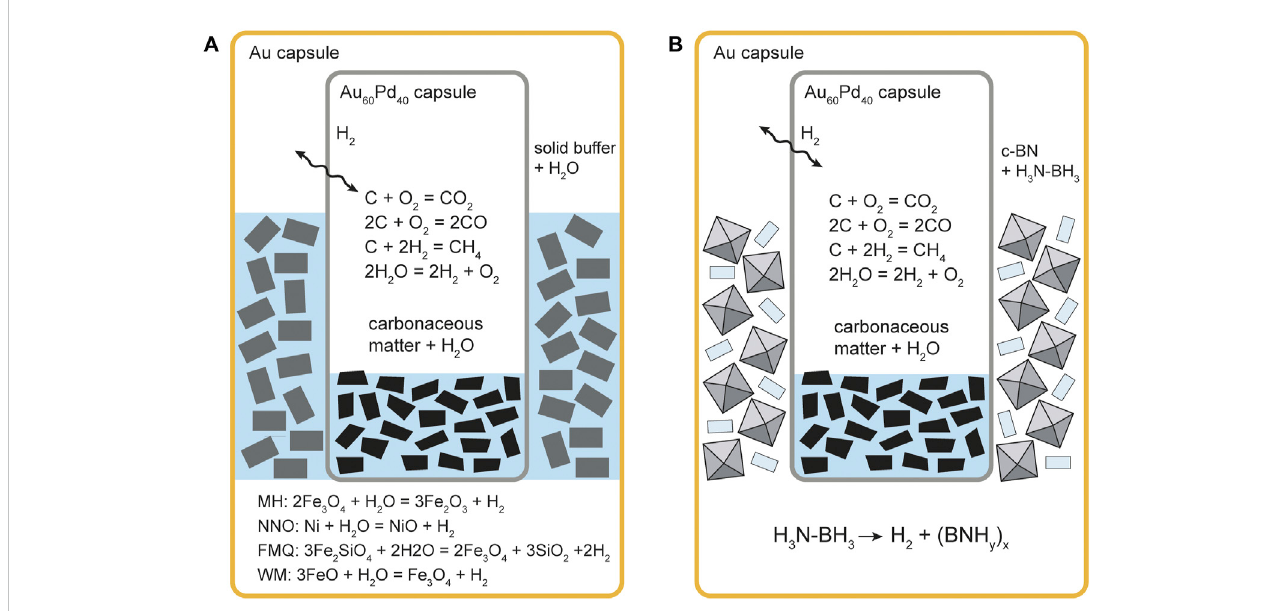
FIGURE 1 Schematic representation of the double capsule setups used to buffer f H 2 in our experiments. (A) solid buffer assemblages; (B) water-hydrogen buffer. The relevant f H 2 -buffering reactions are shown together with the equilibria that involve the COH fl uid in the inner capsule. In (B) ammonia borane is mixed with grains of inert cubic boron nitride (c-BN) to prevent the collapse of the outer capsule.